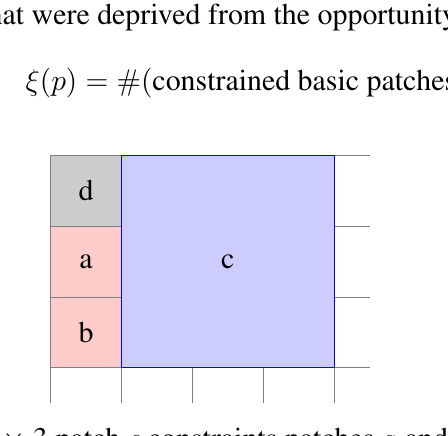
Figure 1. The 3 × 3 patch c constraints patches a and b to be 1 ×